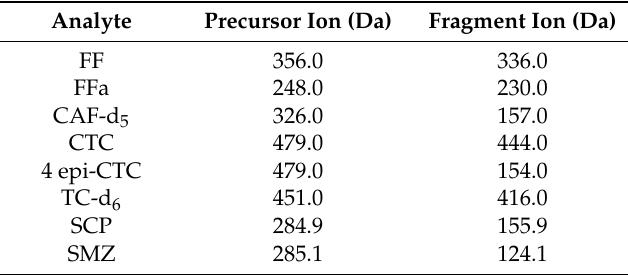
Table 1. Monitored ion